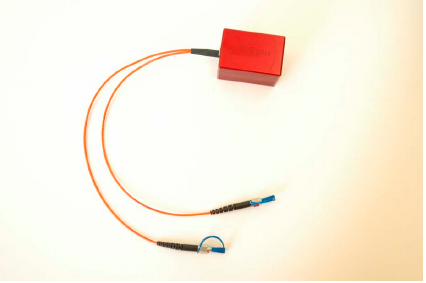
Figure 6. A miniature FTS, including driving electronics, MEMS and fibers. (Reprinted with permission from Reference [29] IEEE).